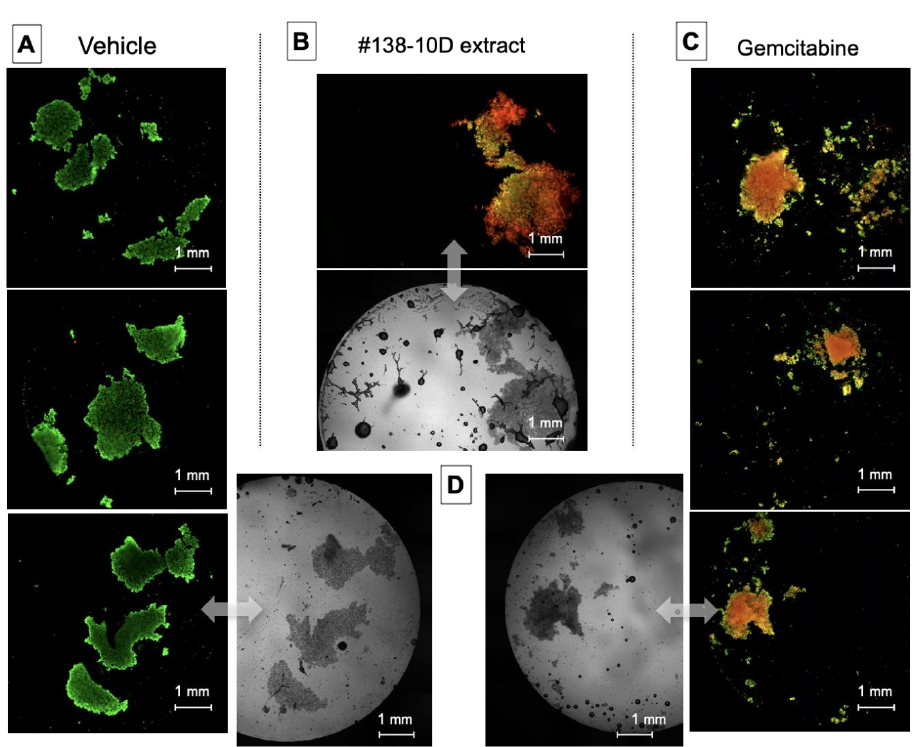
Figure 1. The effect of ethanolic extract of clone #138 on 3D-cultured cells’ viability. Pancreatic cancer cells seeded at 10 5 cells/mL were injected and grown in liquid pearls at a volume of 150 µ L for 24 h, then exposed to ethanolic extract #138-10D (80 µ g/mL), vehicle or Gemcitabine (80 µ M). After 24 h of incubation, the cells were labeled (Calcein-AM = green–living cells and propidium iodide = red–dead cells). The composite image of the two channels was analyzed by imaging